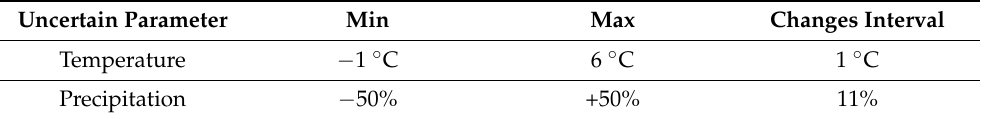
Table 1. Climatic change range (8 temperature and 10 precipitation intervals which form 80 potential climate combinations). Uncertain Parameter Min Max Changes Interval Temperature − 1 ◦ C 6 ◦ C 1 ◦ C Precipitation − 50% +50%